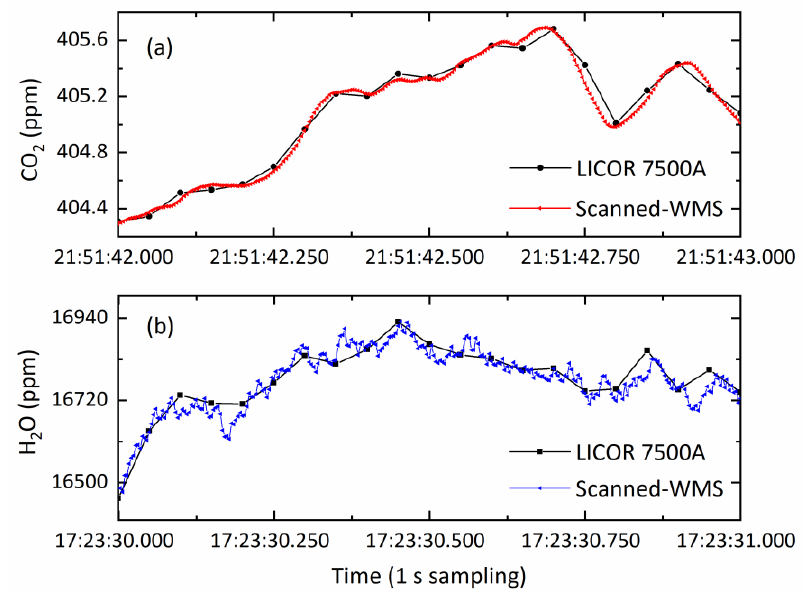
Figure 10. Examples of a 1-s comparison measurements of ( a ) CO 2 and ( b ) H 2 O show detailed results by the scanned-WMS sensors (at 500 Hz data rate) and LI-7500A (at 20 Hz).